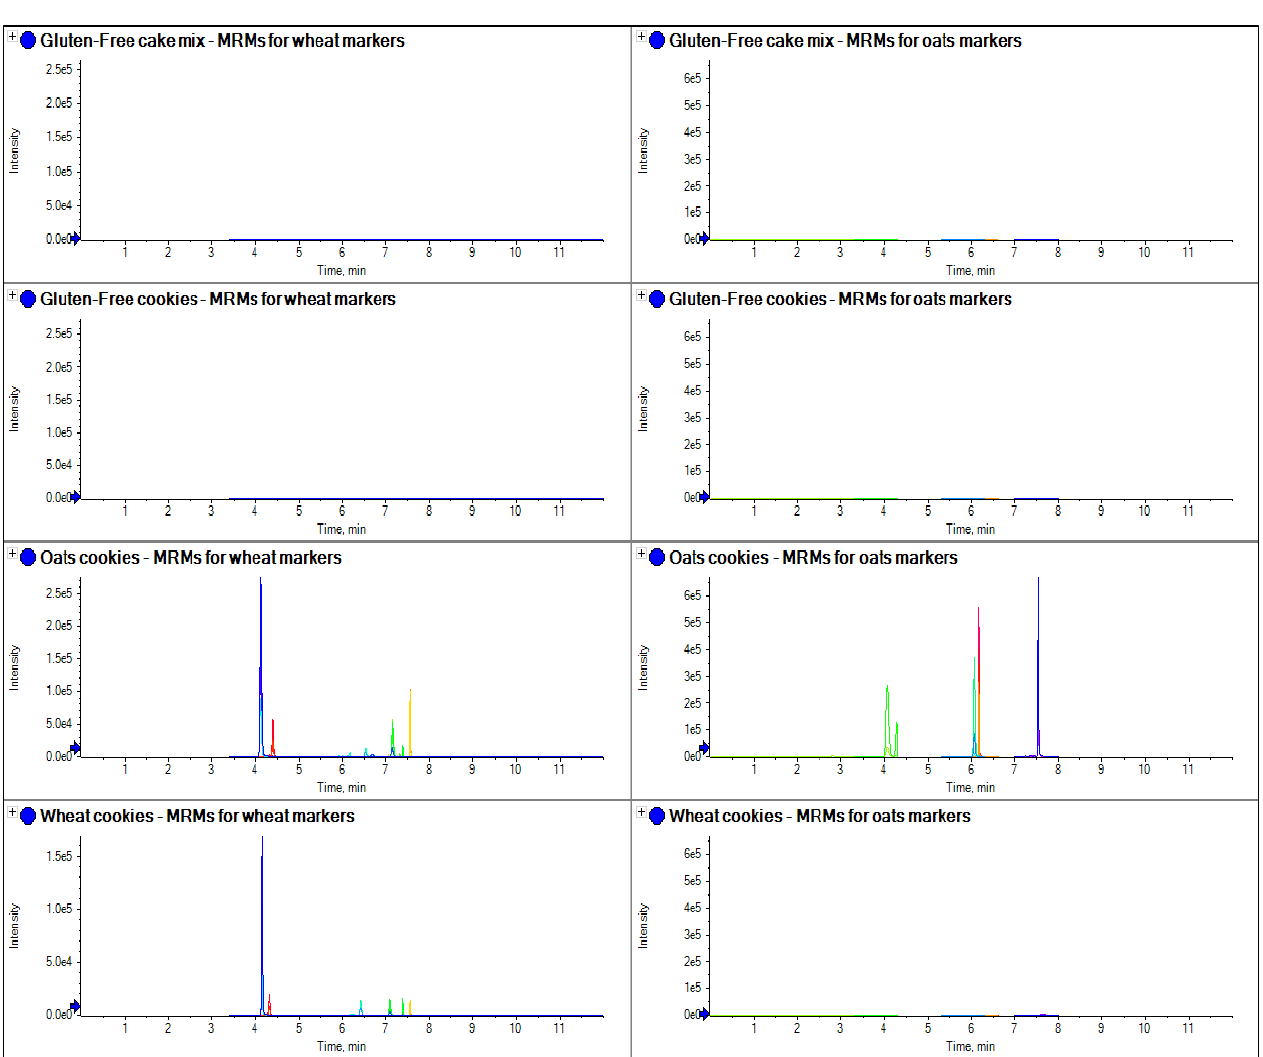
Figure 8. The comparison of extracts from several samples of food collected from a local supermarket and analyzed for gluten markers for oats and